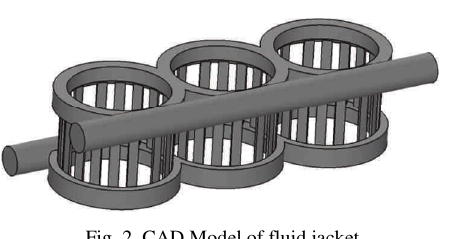
Fig. 2. CAD Model of fluid